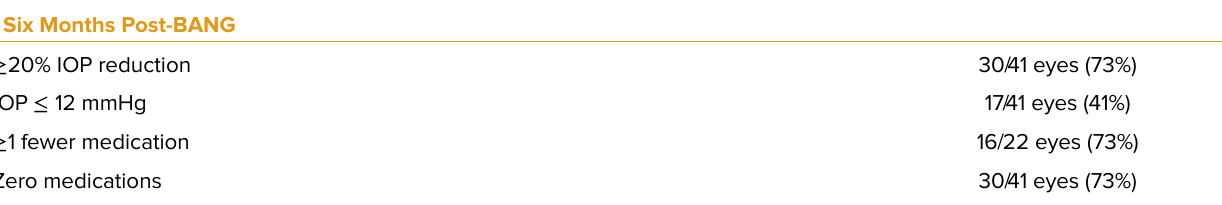
Table 4. Stratification of postoperative month six data Six Months